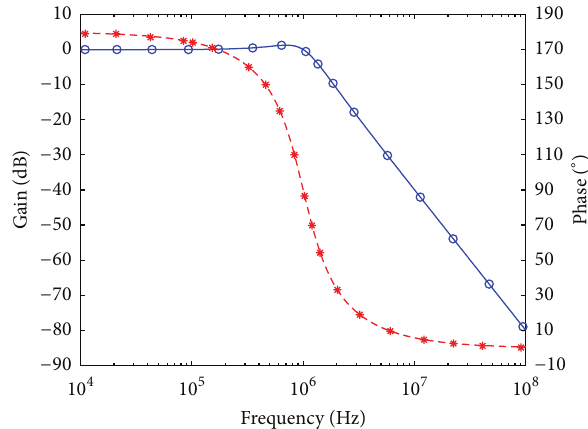
Figure 8: Simulated gain-frequency and phase-frequency responses of inverting low-pass filter at 𝑉 𝑜2 ( ∘ : simulated gain; ∗ : simulated phase; — and ---: theoretical curves).